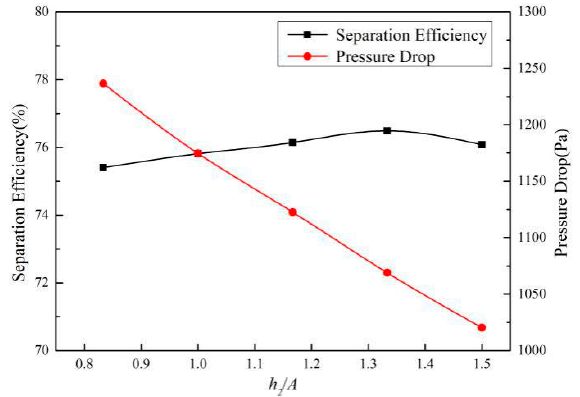
Figure 11. Effect of the distance between vortex finder and gas outlet tube ( h 2 /A ) on efficiency and Figure 11. E ff ect of the distance between vortex finder and gas outlet tube ( h 2 / A ) on e ffi ciency and pressure drop. pressure